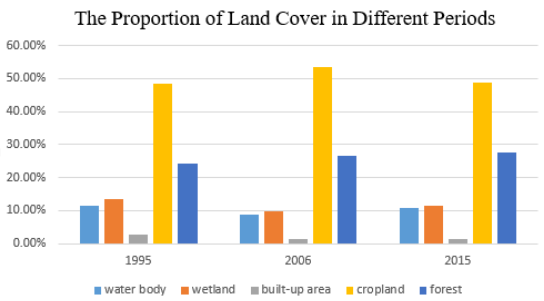
Figure 4. The proportion of land cover in different